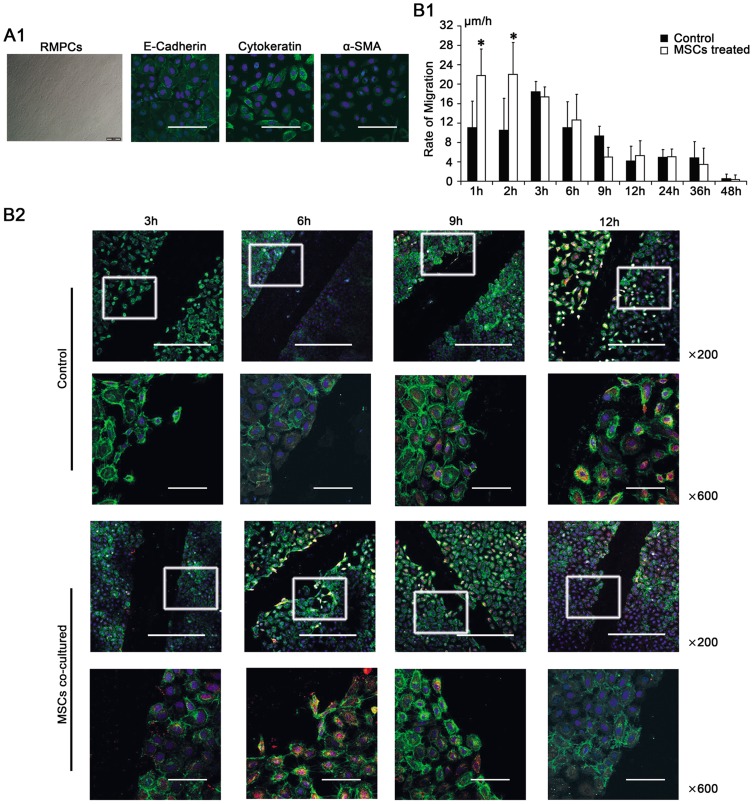
Effects of mesenchymal stem cells (MSCs) on the repair of rat peritoneal mesothelial cells (RPMCs) following mechanical injury.(A). Characteristics of primary RPMCs cultures. (A1). Photomicrograph showing the cobblestone-like appearance of the epithelioid phenotypes. Magnification  = ×100. (A2). An immunofluorescence evaluation revealed that RPMCs expressed E-Cadherin (green) and Cytokeratin (green), but only weakly expressed α-SMA (green). Nuclei were stained with DAPI (blue). Magnification  = ×600. (B). The effects of MSCs on the migratory and proliferative capacities of mechanically injured RPMCs. (B1). Microscopy of RPMCs migrating to the edge of the wound to show the migratory velocity (μm/h). During the first 2 h, injured RPMCs co-cultured with MSCs showed a greater migratory velocity. * compared with control group, p <0.05, n  = 3, respectively. (B2). Immunofluorescence analysis with PCNA (red) and E-Cadherin (green) revealed that the proliferation peak of injured RPMCs co-cultured with MSCs was accelerated to 6 h after scraping, whereas the proliferation peak was 12 h after scraping in control group. Nuclei were stained with DAPI (blue). Magnification  = ×200 and ×600.